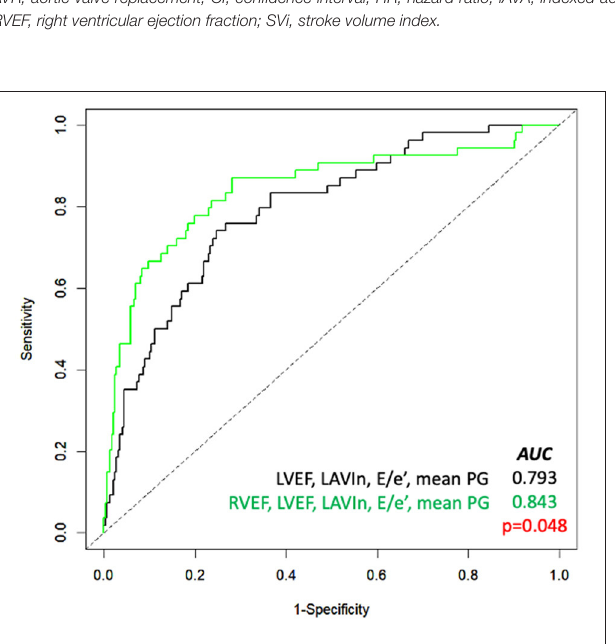
FIGURE 2 | Receiver-operating characteristic curve analysis for prediction of cardiac events. Comparison of the area under the curve (AUC) of several parameters (black line) and with RVEF added (green line). LAVIn, minimum left atrial volume index; LVEF, left ventricular ejection fraction; PG, pressure gradient; RVEF, right ventricular ejection